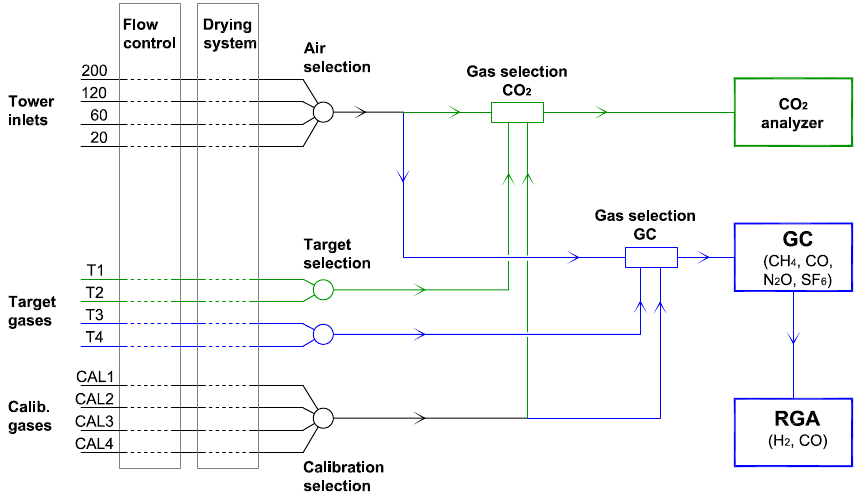
Fig. 3. Period C: general schematic of the Cabauw gas control system for selection of ambient air sampling level, targets and calibration gases. Connections denoted “Calib gases” also include working standard, archive standards and NOAA secondary standards. All sample lines are permanently